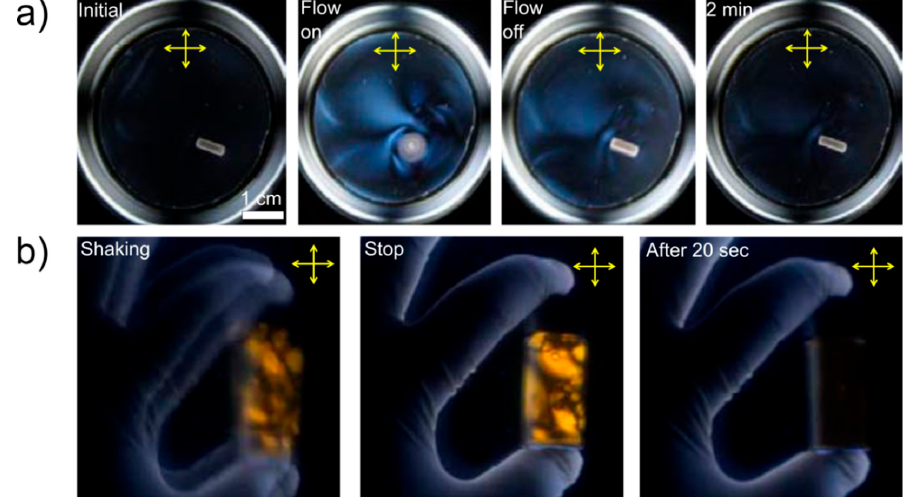
Figure 9. Time series of polarized photographs showing the temporary flow-induced alignment of graphene oxide flakes in the isotropic phase by ( a ) magnetic stirring and ( b ) manual shaking. Reprinted by permission from Springer Nature: Nature Materials, Shen et al. [37] ©